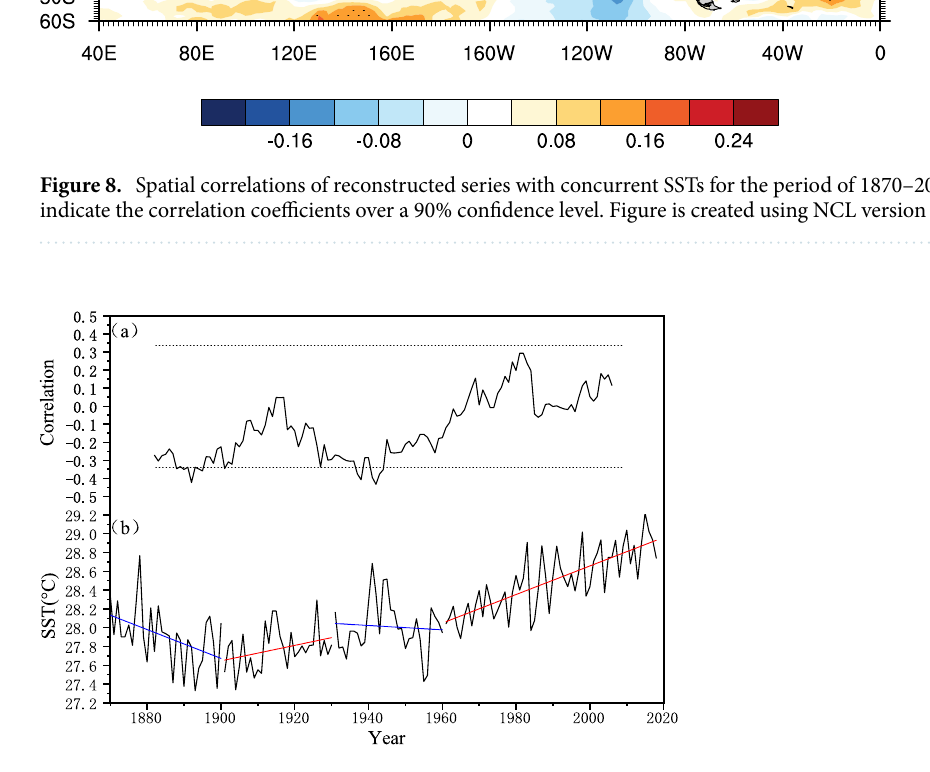
Figure 9. ( a ) Running 25-year correlations between reconstructed scPDSI and the ENSO index calculated using SST anomalies over NINO3.4. ( b ) Time series of mean SST in the tropical Indian Ocean (10° S–10° N and 50°–94° E) with linear trends for different periods. Dotted lines denote the 90% confidence